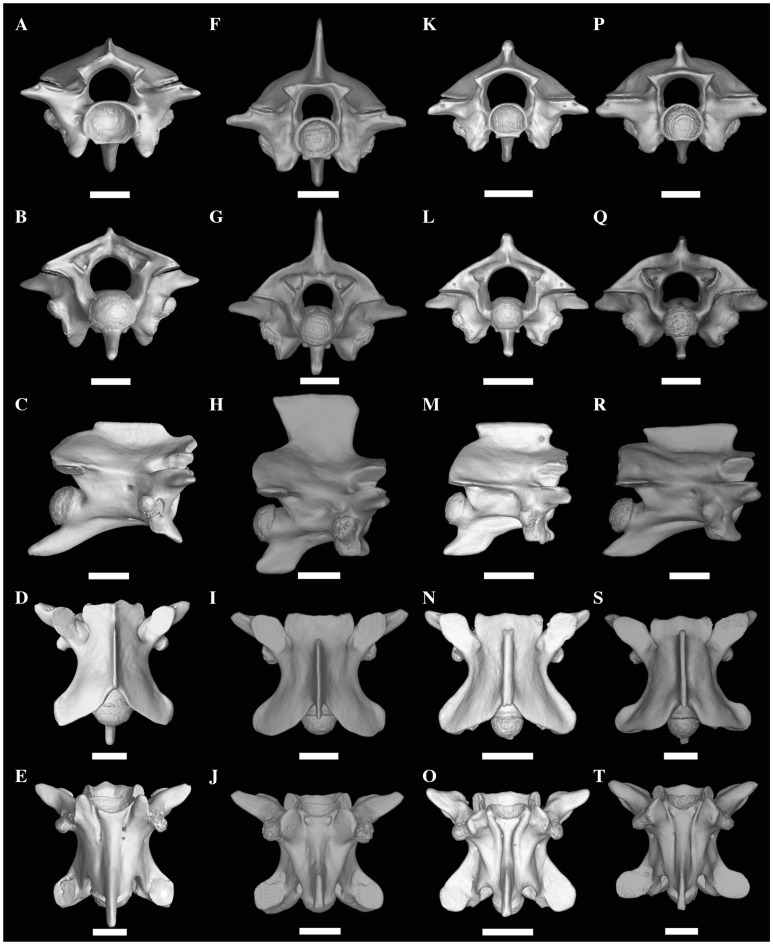
Mid- to posterior trunk vertebrae of Causus
difilippi (A-E), Cerberus rynchops
(F-J), Cyclocorus lineatus (K-O), and
Sinomicrurus macclellandi (P-T).Three-dimensional surface and cutaway views based on high resolution
X-ray computed tomography. A, F, K, P, anterior views; B, G, L, Q,
posterior views; C, H, M, R, right lateral views; D, I, N, S, dorsal
views; E, J, O, T ventral views. A-E, scale bar = 5 mm; F-J, scale
bar = 2mm; K-O, scale bar = 1mm; P-T, scale bar = 1mm.